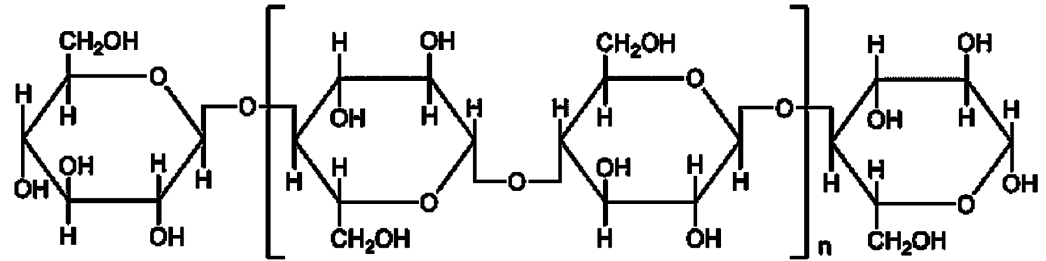
Figure 1. Cellulose structure (Reprinted with permission from [45]. Copyright 2014, Elsevier).